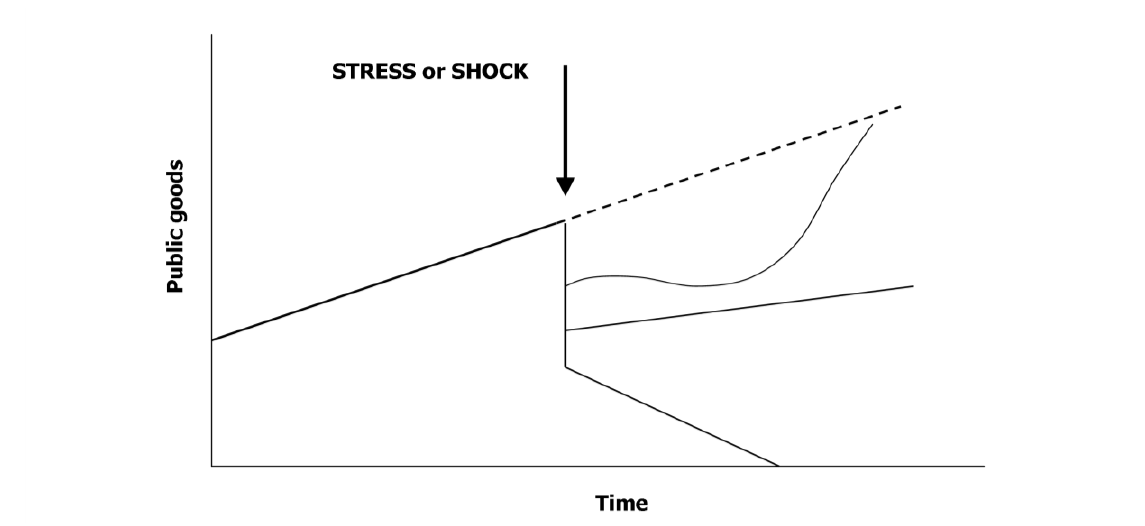
Figure 2. Relabelled Conway